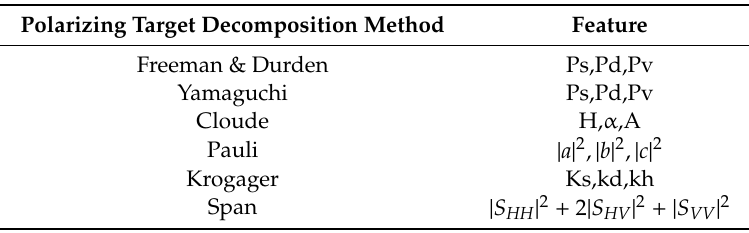
Table 3. Polarization